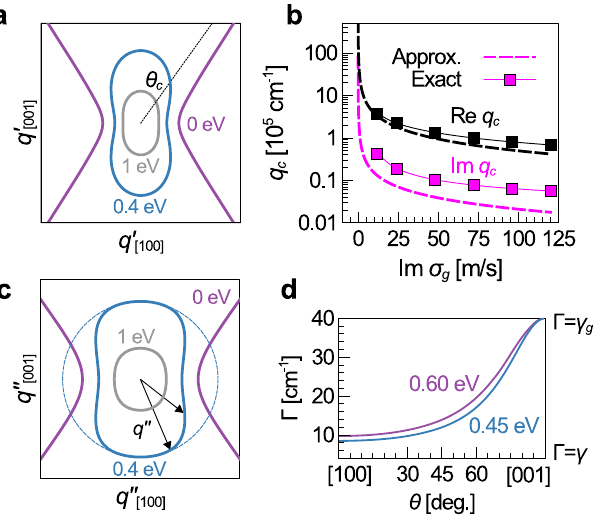
Fig. 4 Directional dissipation and topological transition point. a IFC evolves with graphene Fermi energy from hyperboloid (0eV) to peanut shape (0.4eV) to extended circle (1eV). At intermediate doping, the IFC in fl ects around the open angle θ c (black dashed line) which marks the HP 3 to SP 3 transformation. b Dependence of momentum q c at θ c on the graphene conductivity modulated by the Fermi energy. The topological transition occurs when q c becomes fi nite upon deviation from charge neutrality in an approximate analytical model (dashed lines). Full electrodynamics calculations (squares) support the trend up to low conductivities . c Loss contour at 0.4 eV shows q '' decreases in hybrid mode (solid blue) relative to uncoupled graphene (dashed blue) as the wavevector (black arrow) rotates awayfromthe [001] direction. The undoped loss contour (purple) diverges at θ c , beyond which no mode exists. d Along the [001] direction, the hybrid mode scattering rate Γ ¼ v g q '' is equal to the graphene scattering rate γ Along the [100] direction, Γ isslightly larger than the phonon scattering rate γ and can be tuned slightly by moderate